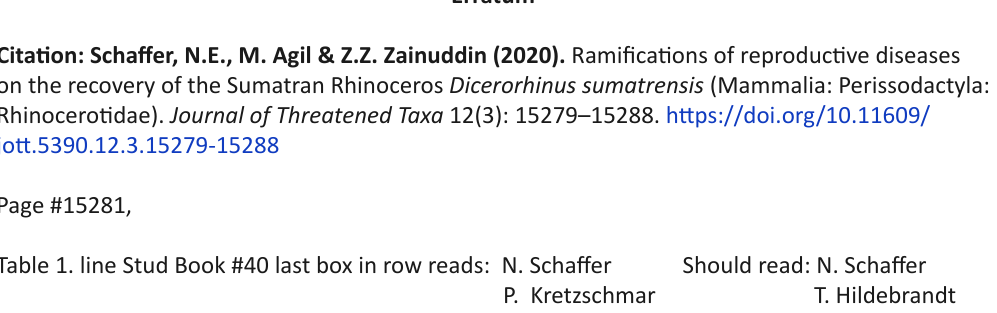
Table 1. line Stud Book #40 last box in row reads: N.